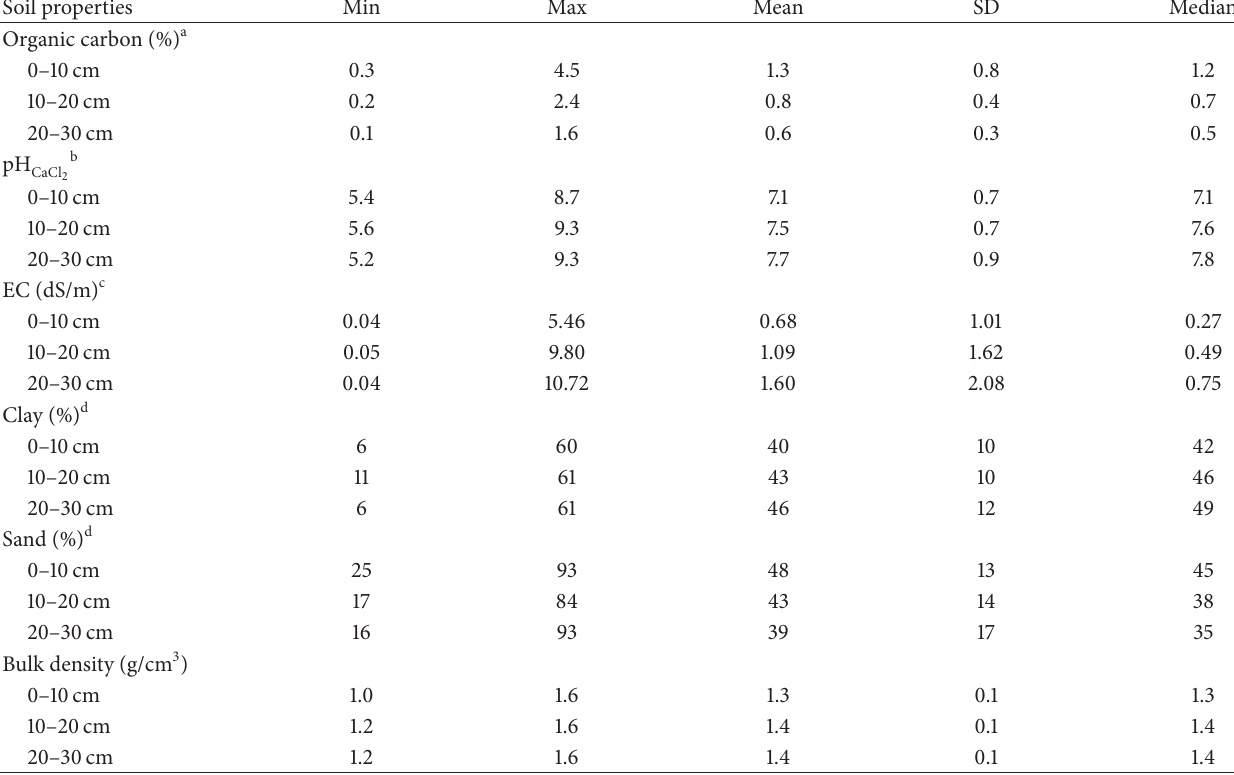
Table 1: Analysed soil chemical and physical properties of 60 sampling points ( 𝑛 = 60 ) at each of three depths from the study area in northern Victoria, south-eastern Australia. Data were produced through conventional analysis methods as well as mid-infrared spectroscopy ∗ . Soil